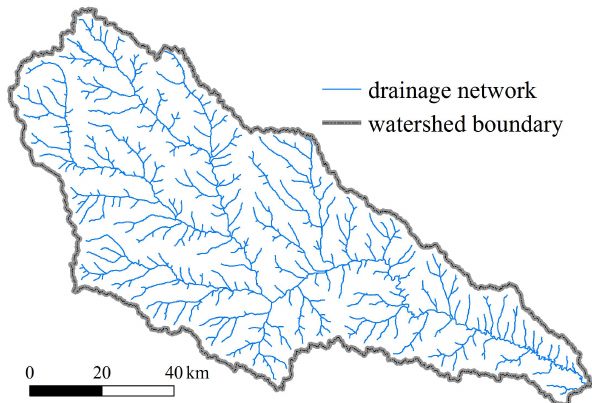
Fig. 2. Spatial distribution of the drainage network in the Yanhe